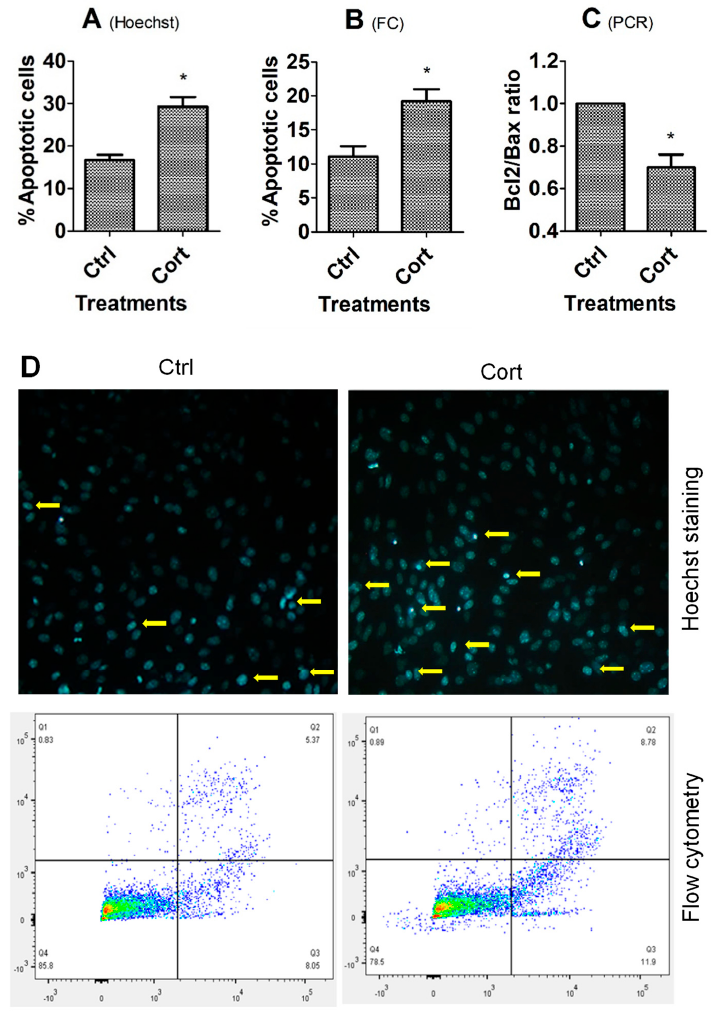
Figure 2. Effects of corticosterone treatment on apoptosis of OECs. Graphs ( A – C ) show percentages of apoptotic cells revealed by Hoechst staining or flow cytometry (FC), and the ratio of Bcl2/Bax measured by RT-PCR, respectively, between untreated control (Ctrl) and corticosterone (Cort) treated cells. Each treatment was repeated 3 times, with each replicate including cells from 2 wells of a 12-well plate from 4 mice. * Indicates significant difference ( p < 0.05) from controls. In graph B, the percentages of apoptotic cells included both early and late apoptotic cells. In graph ( C ), the ratio of Bcl2/Bax mRNA in Ctrl cells was set to one and the ratio in Cort-treated cells was expressed relative to it. Panel ( D ) shows images and the flow cytometry graphs of OECs in the Ctrl or Cort groups. The OEC images were obtained under a fluorescence microscope after Hoechst staining. Original magnification was 400×. Arrows indicate representative apoptotic cells with pyknotic nu- clei heavily stained by Hoechst 33342. The flow cytometry graphs were obtained following annexin- V and PI staining. The healthy, early and late apoptotic are located in the Q4, Q3 and Q2 area, re- spectively. The Q1 area contains necrotic cells and mechanically damaged cell debris.